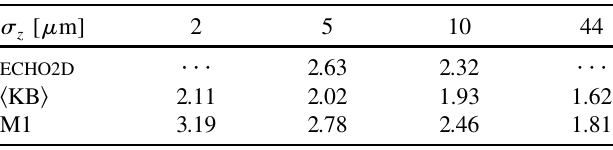
TABLE I. Total loss factor per meter of length calculated using different models and ECHO2D in the sample structure for different bunch length is presented in [ kV = pC m